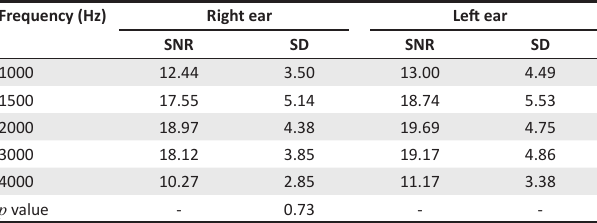
TABLE 3: Right and left transient evoked otoacoustic emission’s signal-to-noise ratio (dB) from normal ears ( n = 40). Frequency (Hz)